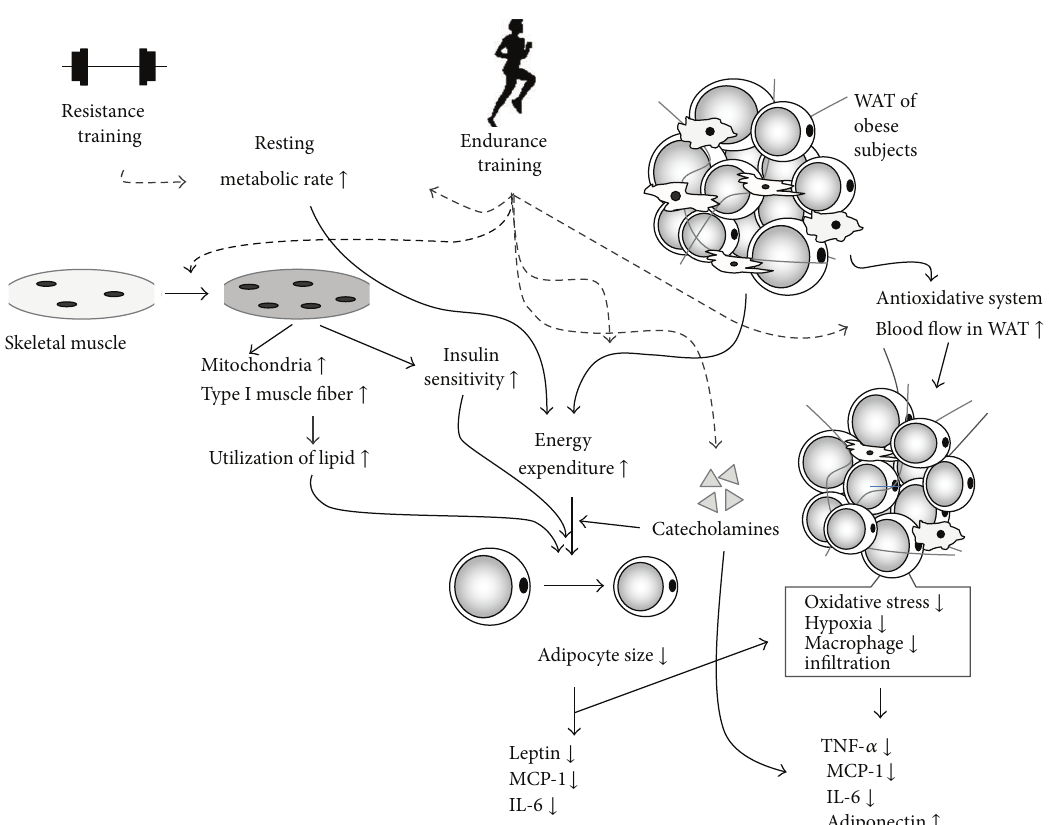
Figure 3: Schematic model for the effects of exercise training on expression of adipokines in WAT. During endurance training, type I muscle fibersinskeletalmuscleareselectivelyusedfortheexecutionofexercises,andtherefore,energyexpenditureusinglipidincreases.Triglycerides within the adipocytes are broken down due to the secretion of catecholamines, and the resultant fatty acids are transported to tissues such as skeletal muscle. When exercise is repeated, adipocyte size is lessened. Decreases in adipocyte size are considered to result in the attenuation of dysregulated expression of adipocyte size-sensitive adipokines, such as leptin and oxidative stress in WAT. Moreover, catecholamine itself seems to correct disarray of adiponectin and TNF- 𝛼 in WAT of obese subjects. In addition, endurance training might suppress oxidative stress and a hypoxic state of WAT due to an enhanced antioxidative system and increases in blood flow, respectively, which lead to the attenuation of the dysregulated expression of inflammatory-related adipokines involving TNF- 𝛼 and MCP-1. In skeletal muscle, endurance training produces transition to type I muscle fiber following the increase in mitochondria biogenesis and enhances insulin sensitivity. Consequently, enhancedglucose/lipidmetabolisminskeletalmuscledecreasesadipocytesize.Ontheotherhand,resistanceandendurancetrainingenhance resting metabolic rate, which is likely to cause the alteration of adipokine expression following WAT mass reduction due to increased energy expenditure in the resting